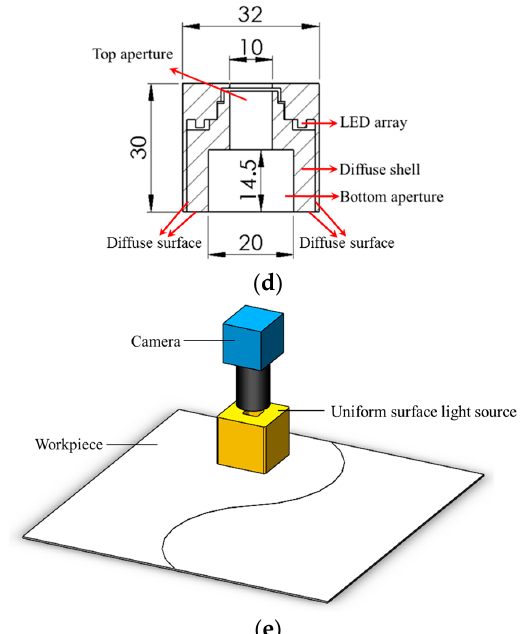
Figure 5. The designed uniform surface light source and its installation. ( a ) The uniform surface light source; ( b ) The outermost shell and the LED array of the light source; ( c ) The diffuse shell of the light source; ( d ) The inner structure of the light source, including the diffuse surface, aperture, and LED array; ( e ) The relative position of the camera, the uniform surface light source, and the workpiece.